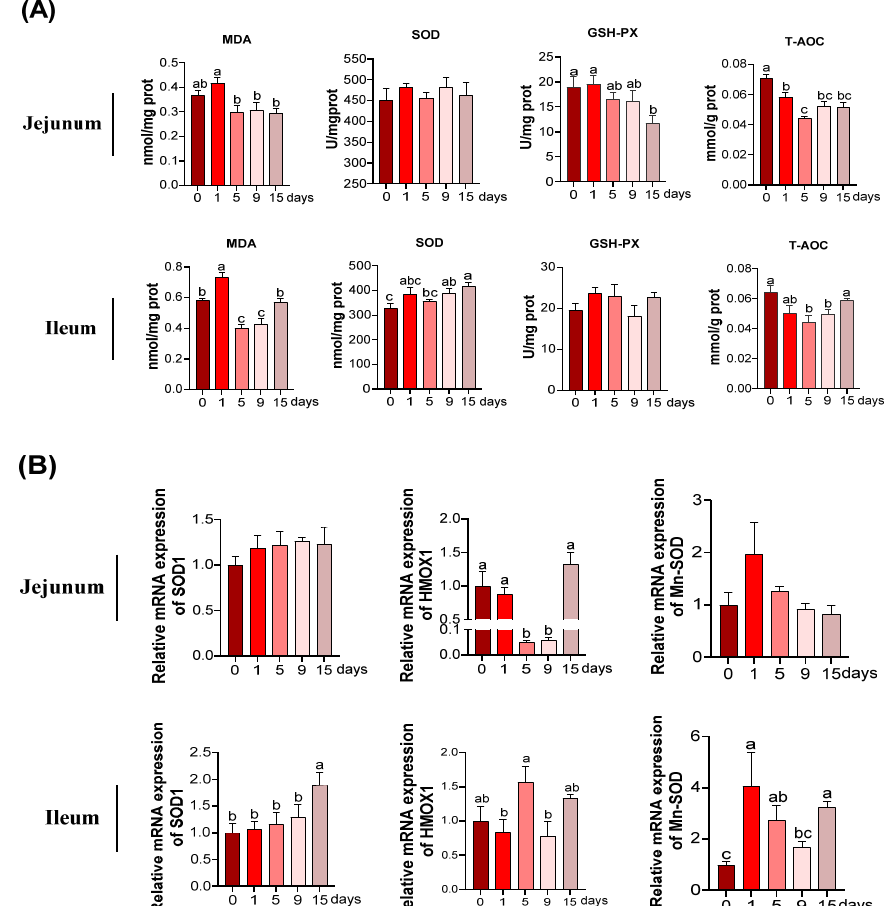
Figure 4. The MDA and anti-oxidative parameters under LPS-induced chronic immune stress: ( A ) the antioxidant enzymes activities and MDA content in jejunum and ileum of piglets; ( B ) the mRNA expression of anti-oxidative related genes. Data represents the mean ± SEM. n = 6. a,b,c Mean values with different letters were considered to be significantly different ( p < 0.05).